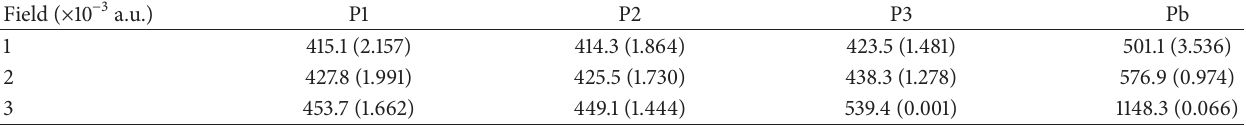
Table 6: Absorption spectra and oscillator strengths of the dipolymers under external electric field. Field ( × 10 −3 a.u.)